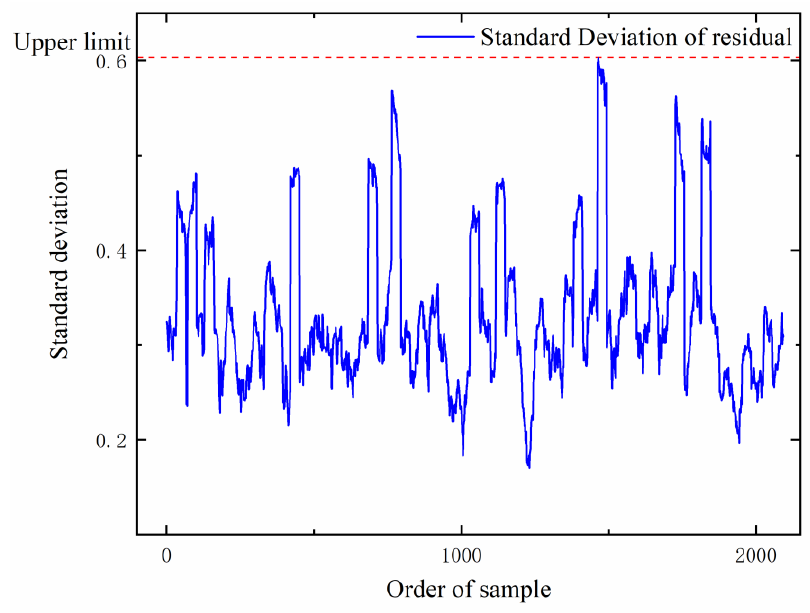
Figure 13. Normal working condition standard deviation curve.